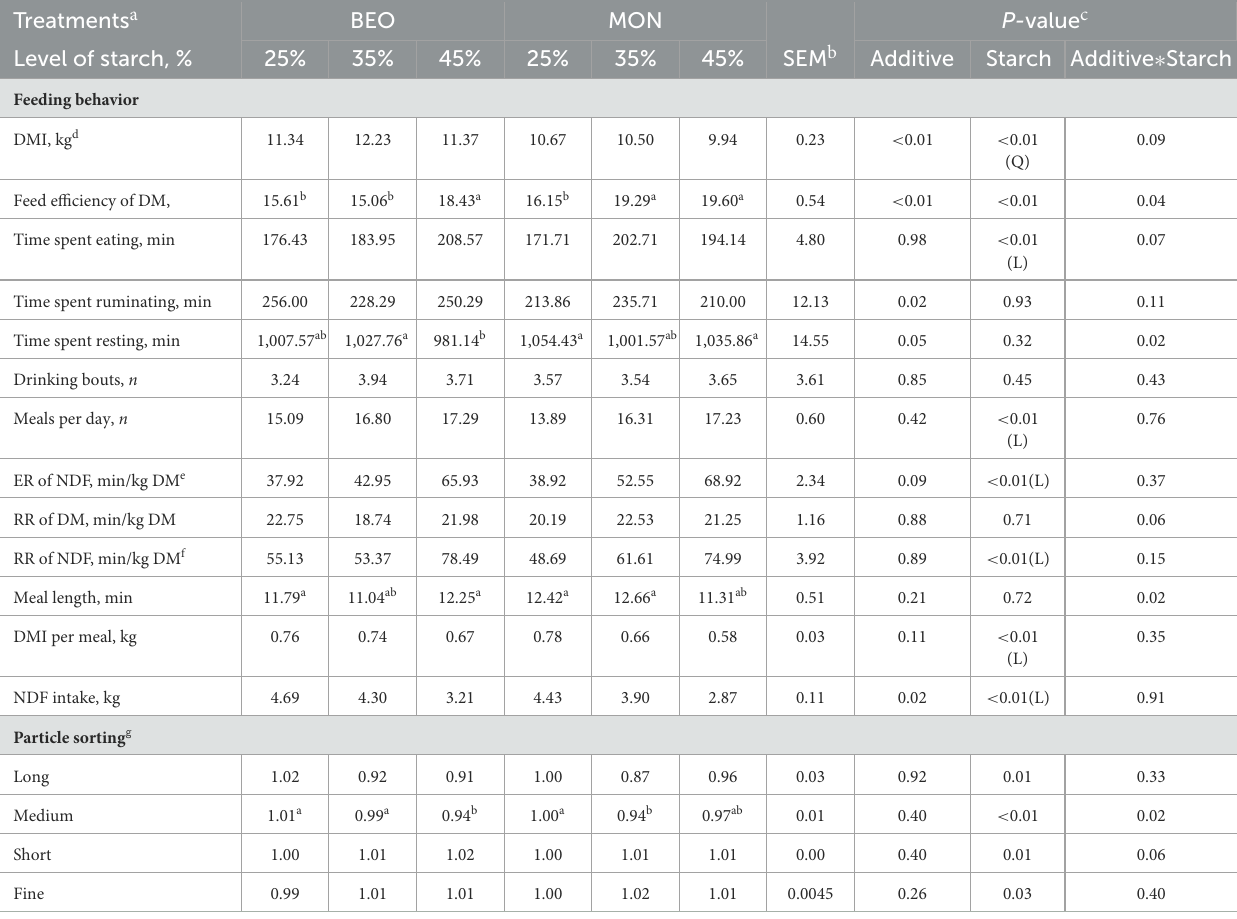
withdifferentsuperscriptsdiffer( P <